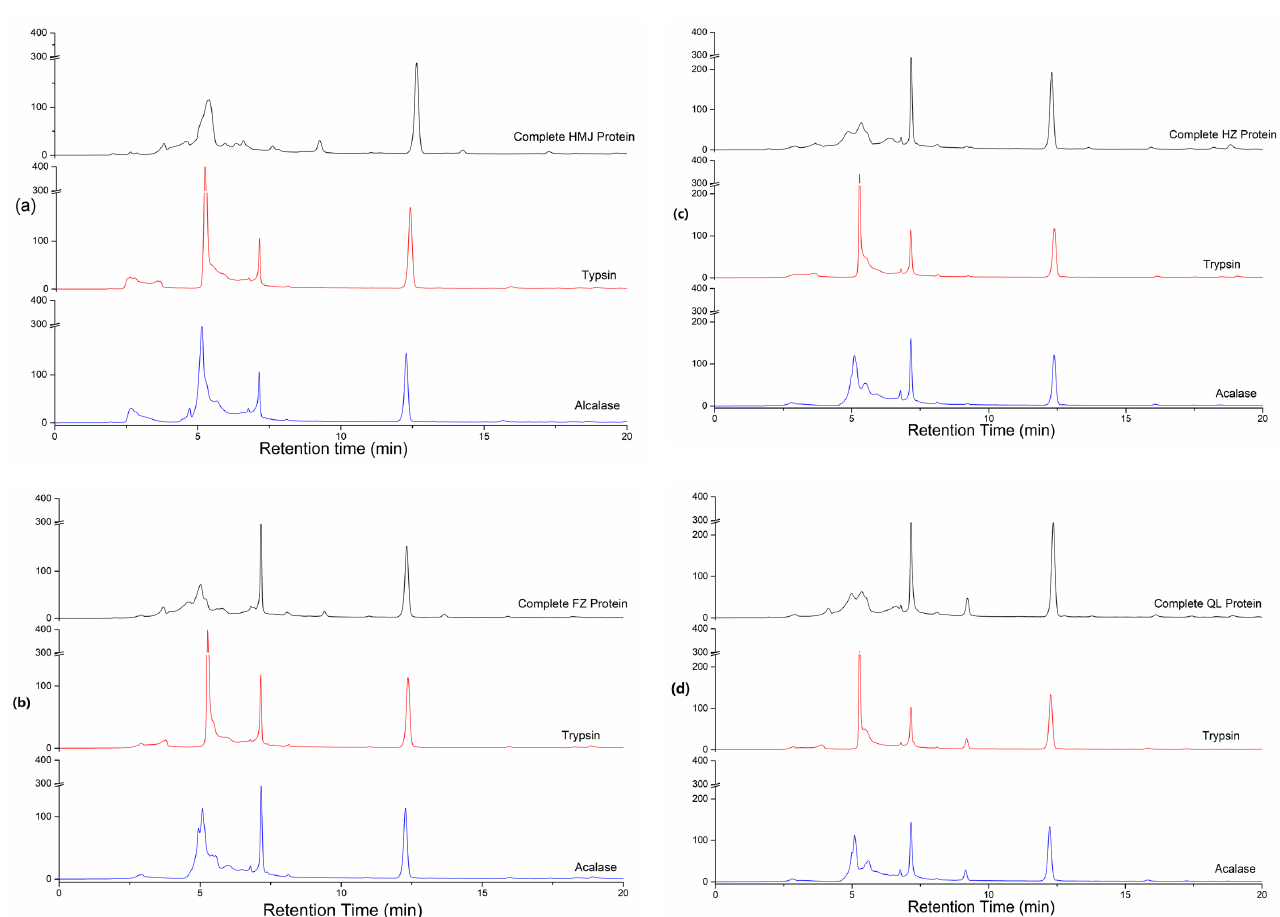
Fig. 3: RP-HPLC absorbance profiles at 215 nm for complete proteins and hydrolysates of HMJ (a), FZ (b), HZ (c), and QL (d).